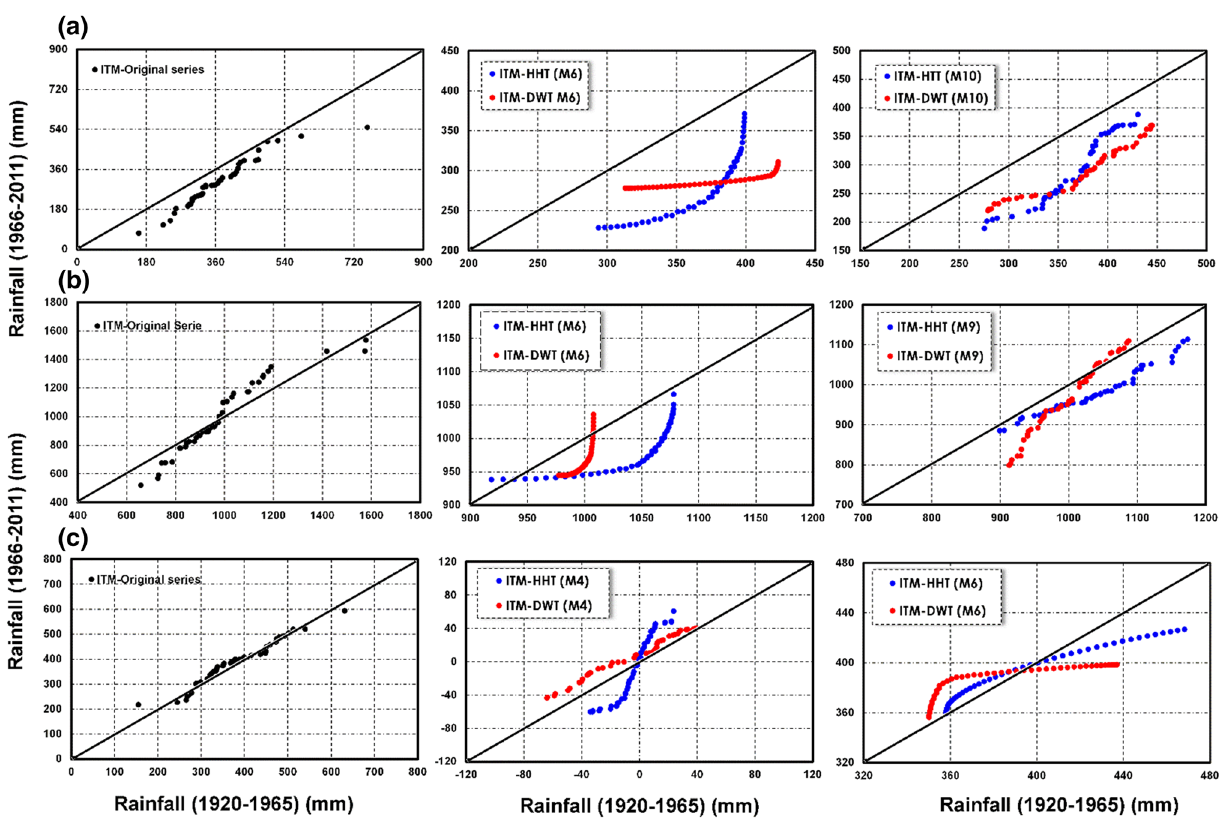
Fig. 7 Representations and comparison of the results of the application of the innovative trend method (ITM) on original series (black points), some proposed models using DWT (red points), and HHT (blue points) (hybrid approach) at a Oued Taria, b Azazga, and c Ain Beida